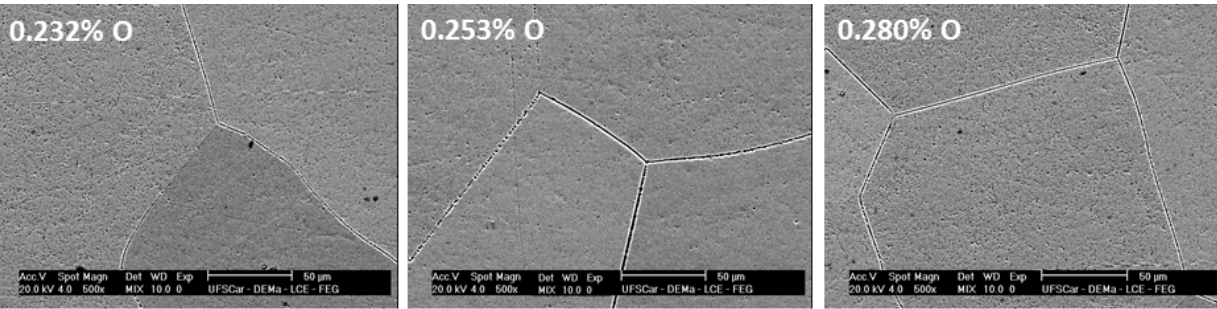
Figure 3. SEM microstructures for the TNZT alloy with 0.232%, 0.253% and 0.280% of